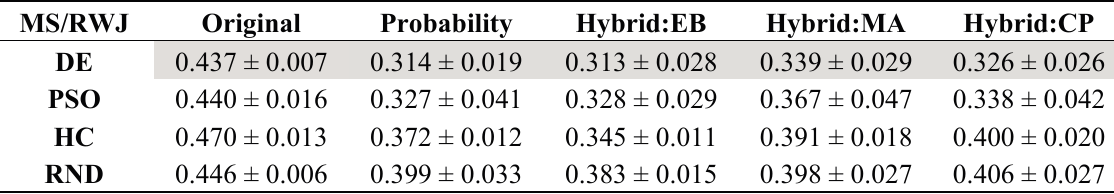
Table 9. RWJ metric scores using the four different search strategies in the Hagadera problem instance. The shaded cells highlight the results of the best performing search